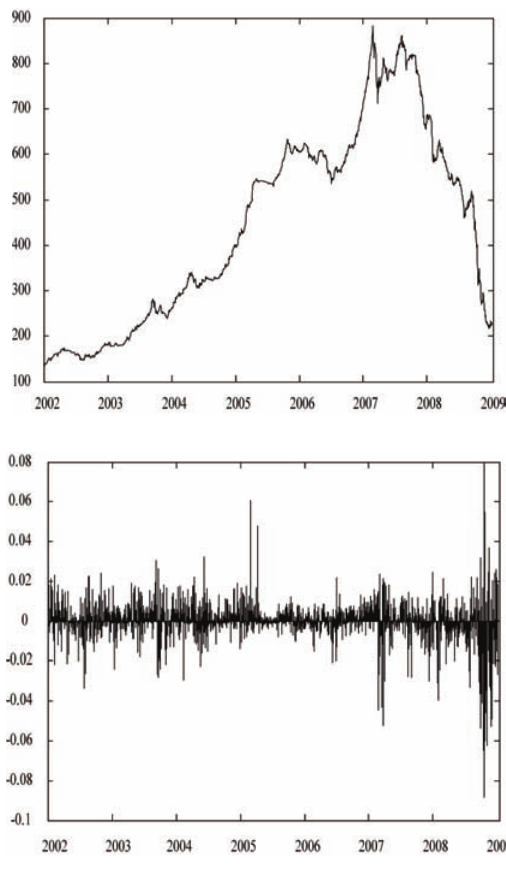
Fig. 4. BALTIC Benchmark Index Values and Return, Period